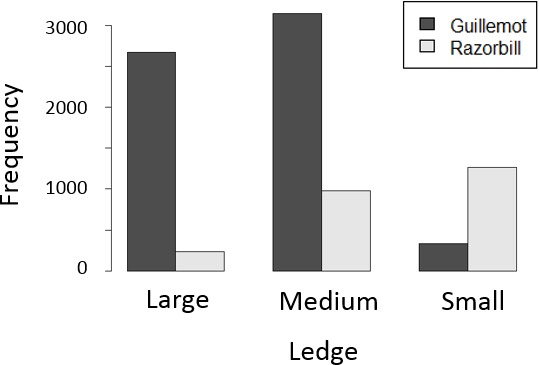
Observations of landings grouped according to ledge size for each species.